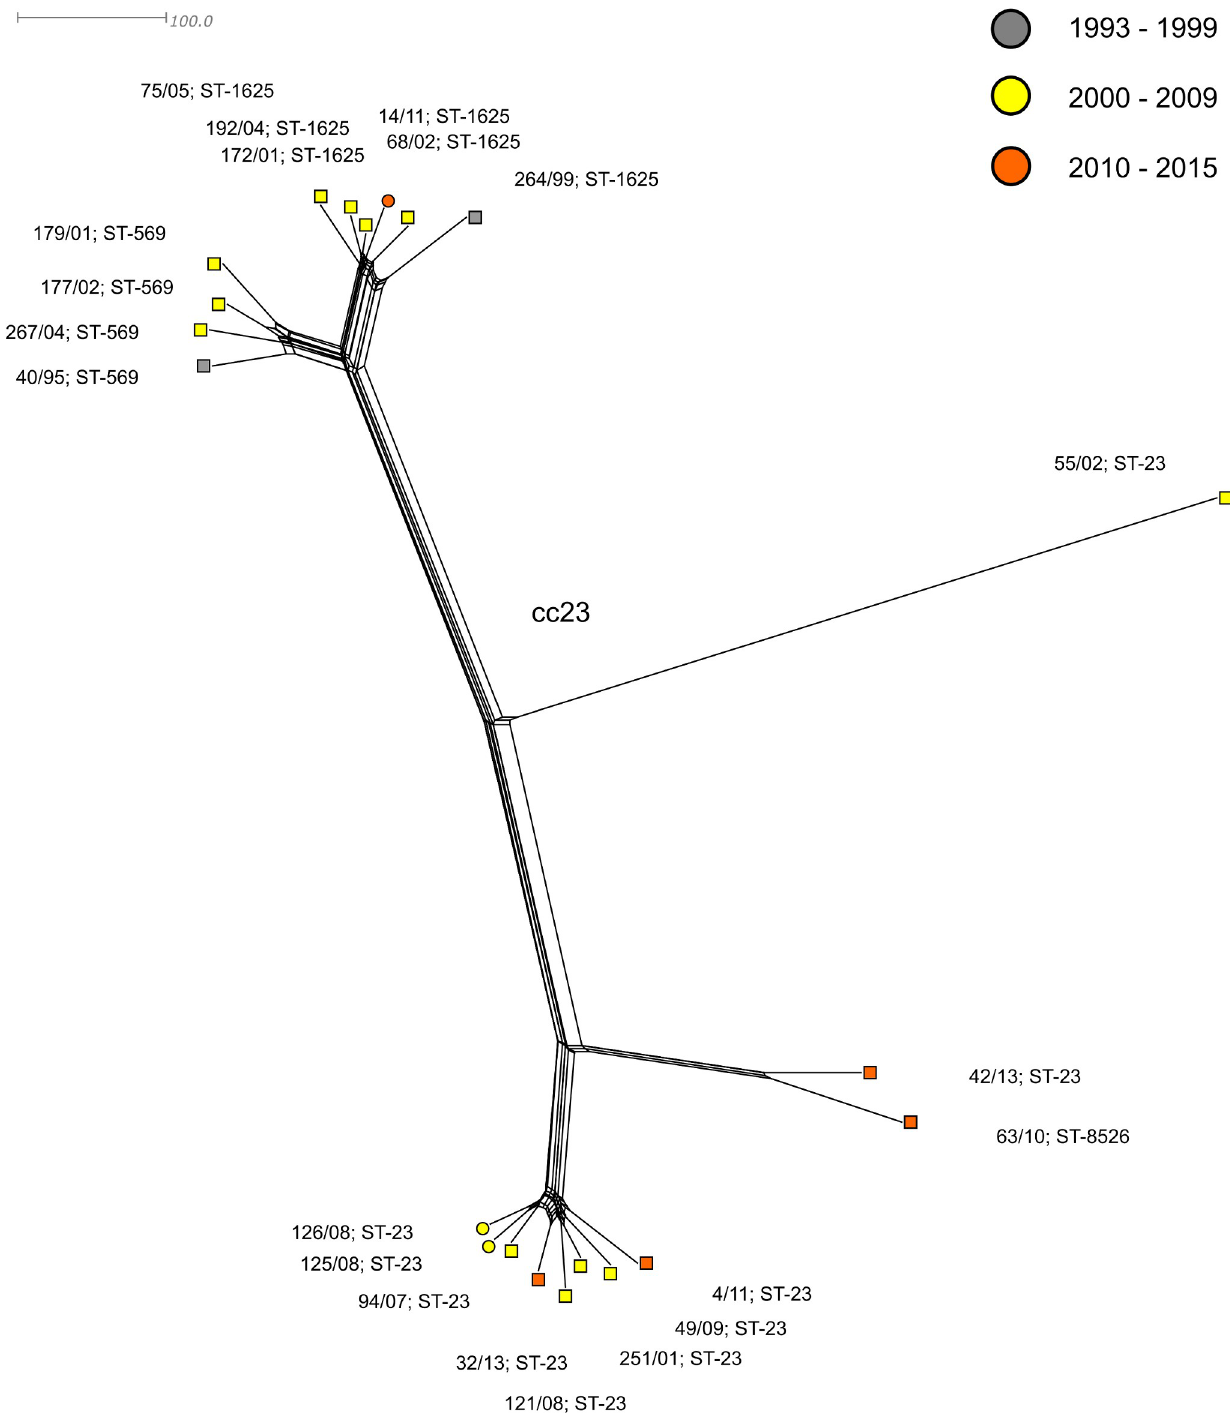
Fig 2. Genetic relationship of N . meningitidis Y isolates collected in the Czech Republic from 1993 to 2018, clonal complex cc23. Neighbour-net network of MenY isolates cc23 (n = 21). Isolates are coloured according to detection year and labelled by their NRL number, ST, and cc. Invasive isolates are marked with a square, carriage isolates with a